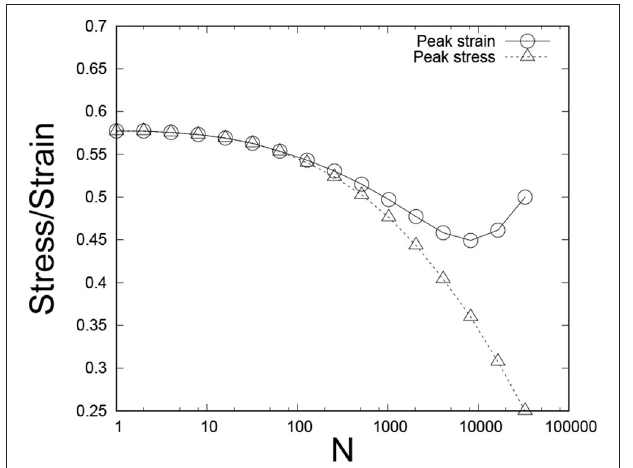
2 14 and averages =